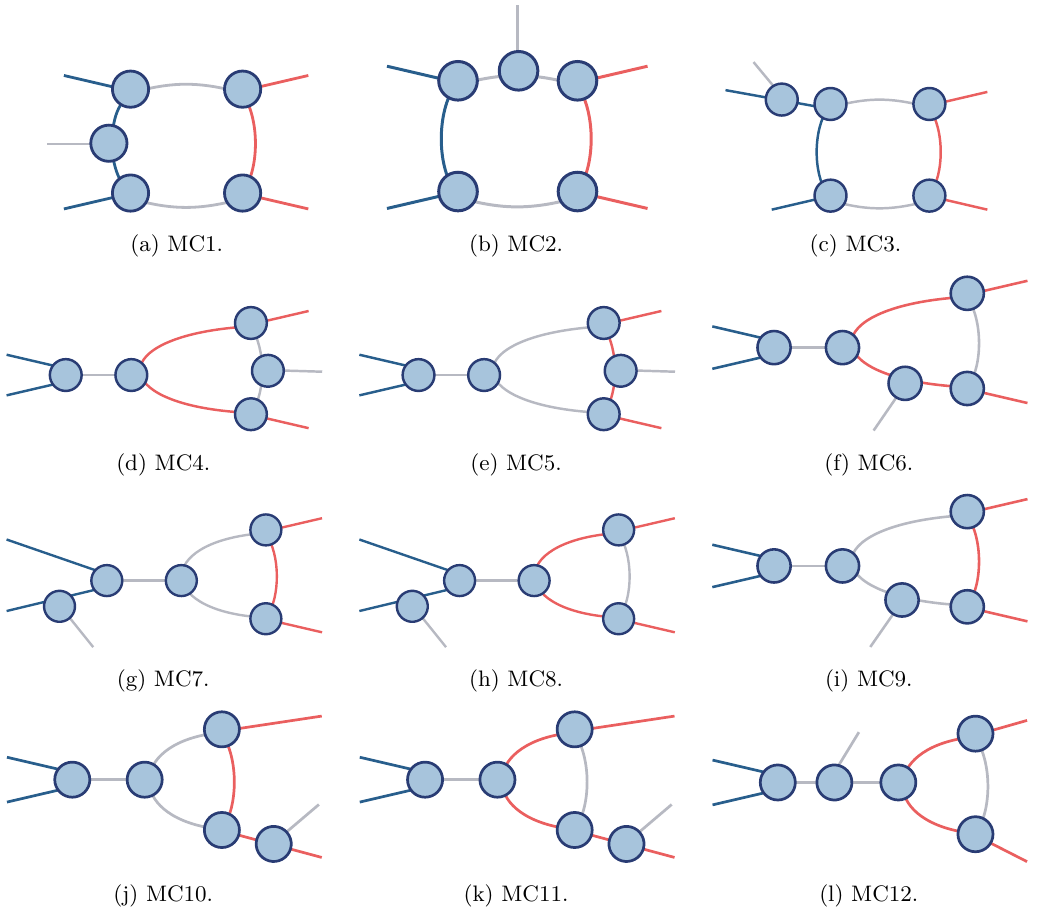
Figure 5 . Maximal cuts MC1-MC12 of the one-loop five-point amplitude. Light blue blobs repre- sent three-point amplitudes, and exposed legs represent on-shell